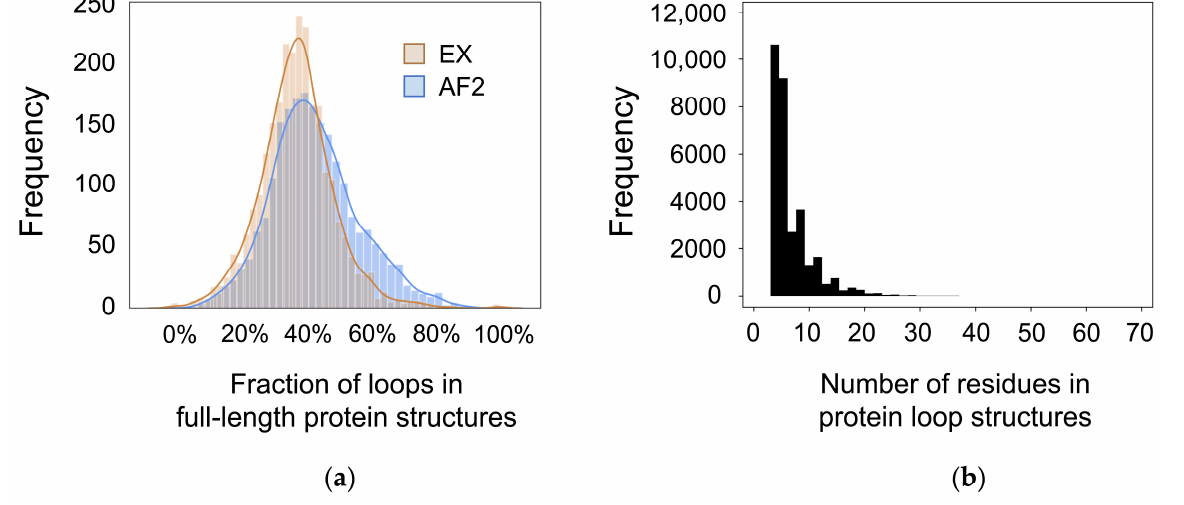
Figure 1. Summary of the dataset. ( a ) Fraction of coiled residues in the full-length protein structures based on DSSP analysis. The tan curve represents DSSP analysis across experimentally determined structures (EX), and the blue curve represents DSSP analysis across AlphaFold 2 predicted structures (AF2). ( b ) Length of each loop structure in the dataset. Loops range from 1 to 65 residues in